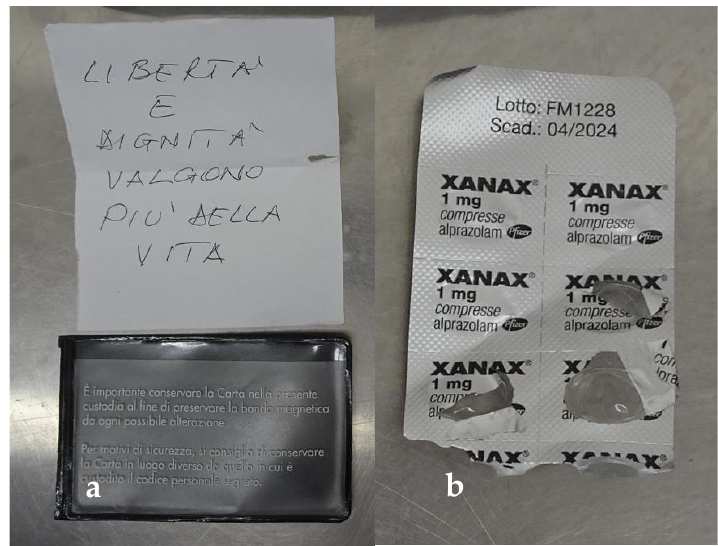
Figure 3. Personal items found in the victim’s clothing pockets: ( a ) the suicide note ( b ) the blister with three pills of a tranquilizer (Xanax, Alprazolam).